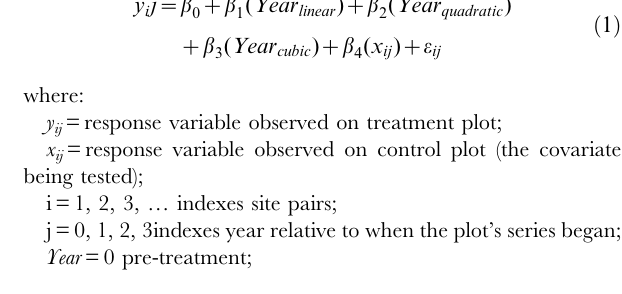
Table 6. Mean percent activity ( 6 SE) for species recorded as common potential nest predators (occurrence/station/day x 100) in tree row edge and grassland interior habitats on the control and tree row removal sites.